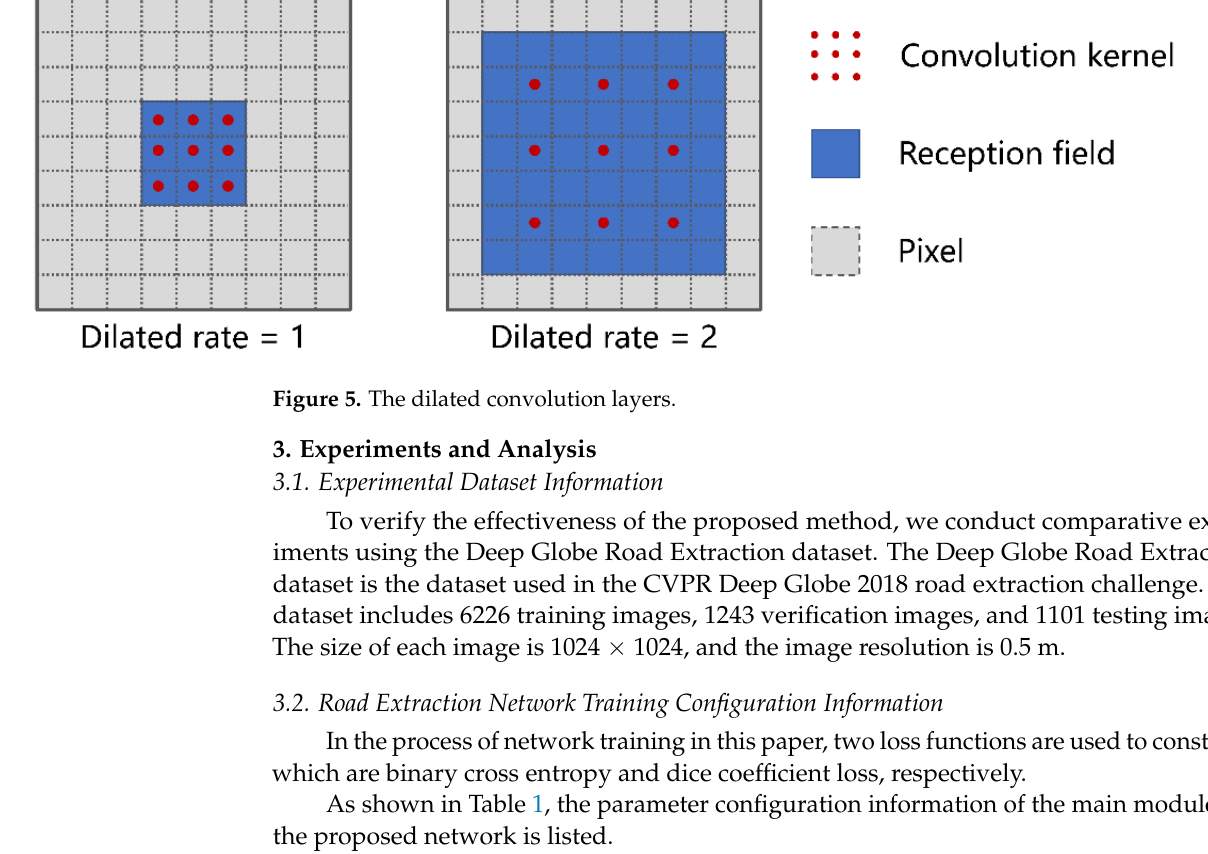
Figure 4. The RDCM schematic.